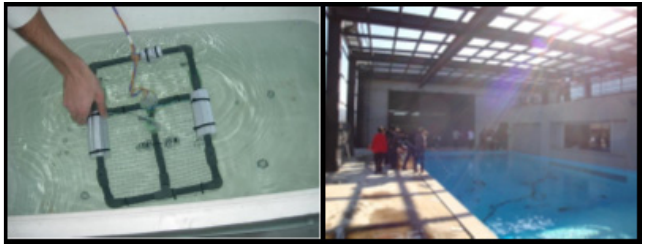
Figure 11. ( Left ) Buoyancy adjustment step. ( Right ) CIRS experimental